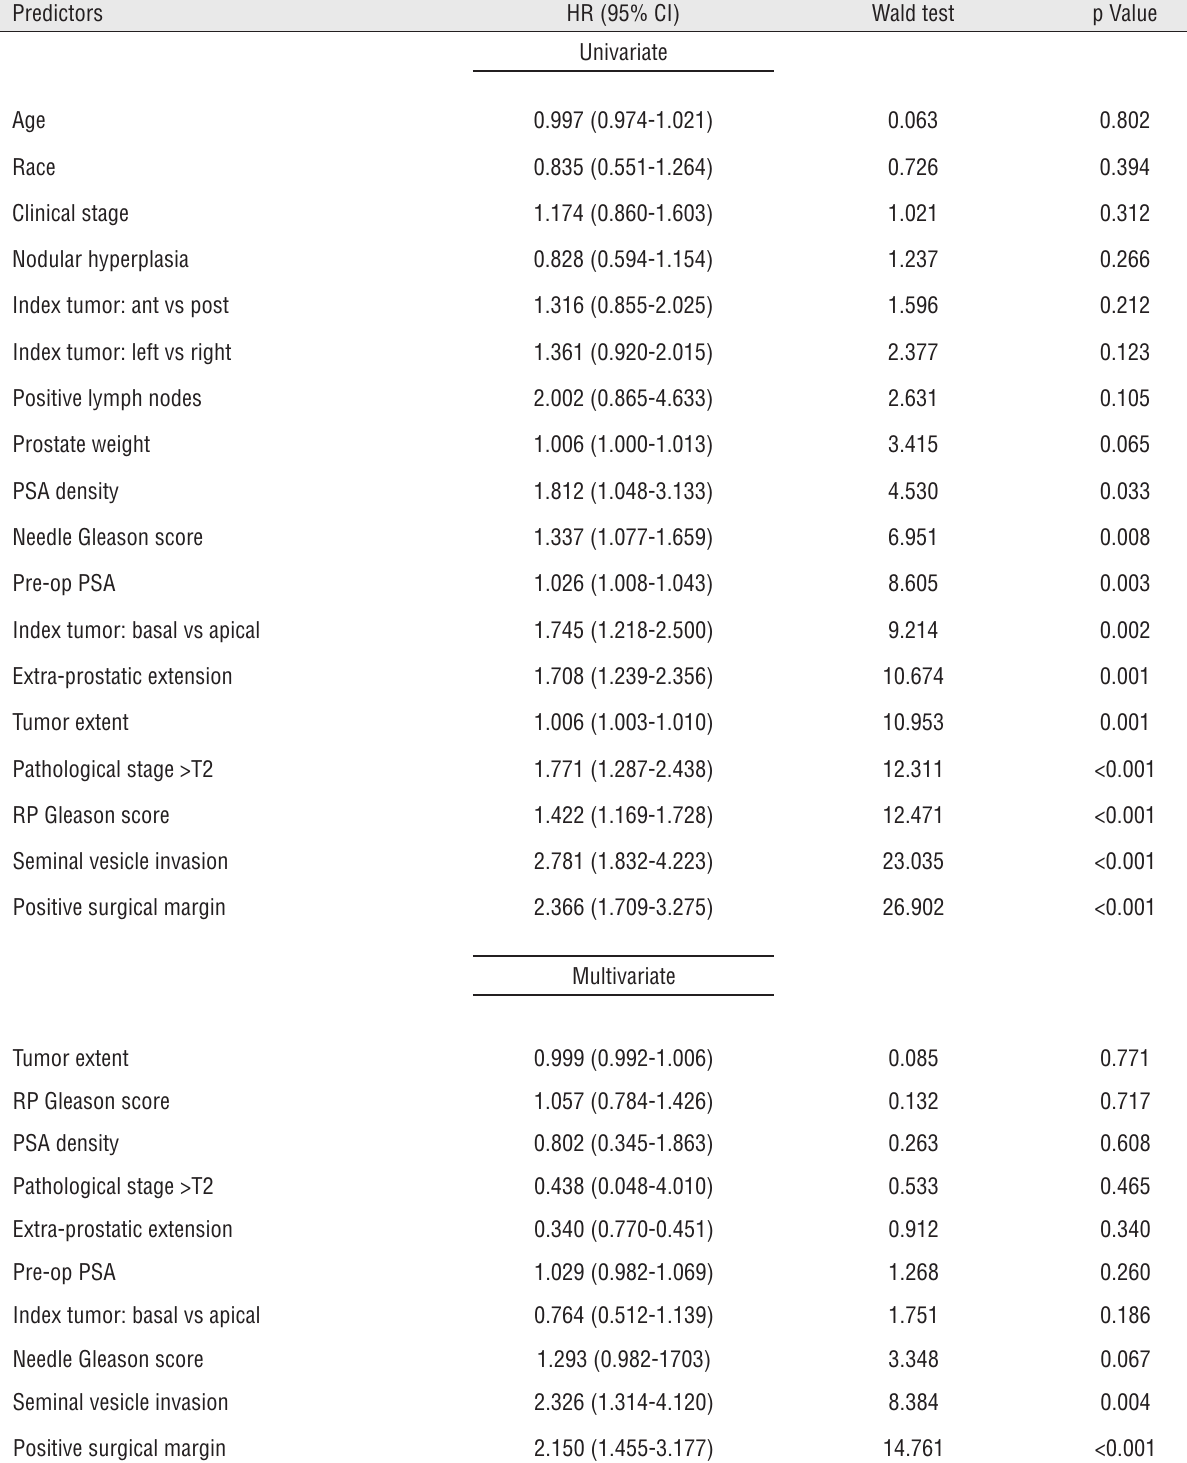
Table 4 - cox univariate and multivariate proportional hazard analysis of several clinicopathological factors predicting shorter time to biochemical recurrence after radical